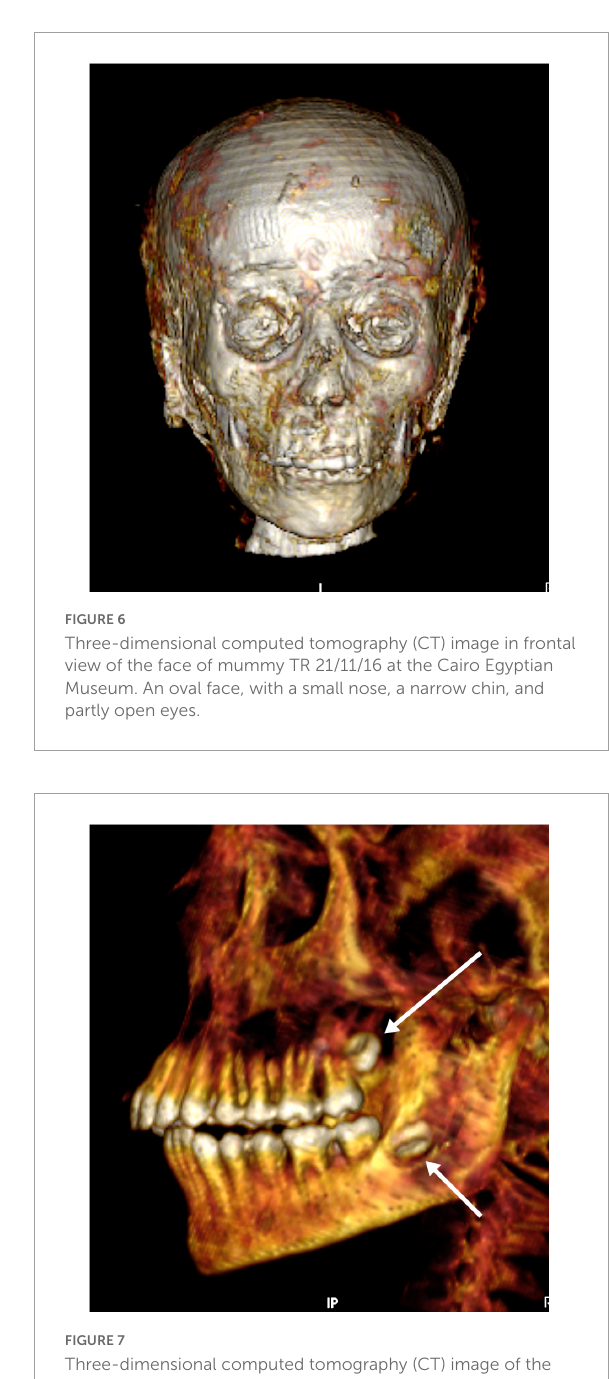
FIGURE7 Three-dimensional computed tomography (CT) image of the teeth of mummy TR 21/11/16 at the Cairo Egyptian Museum in left lateral view. A mild overbite and non-erupted upper (long arrow) and lower (short arrow) third molar